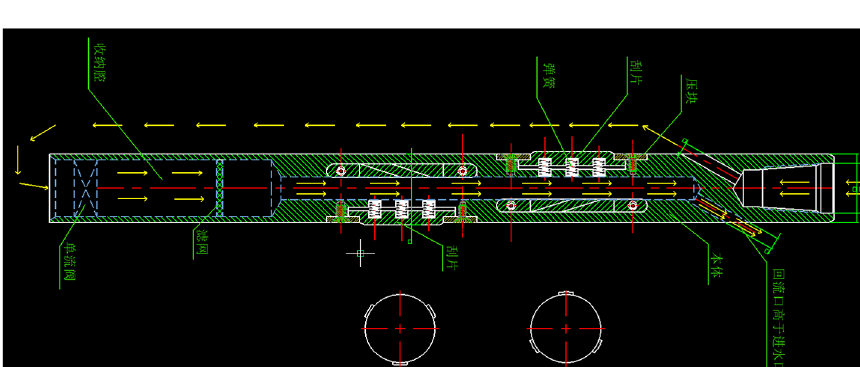
Fig. 10 Structure diagram